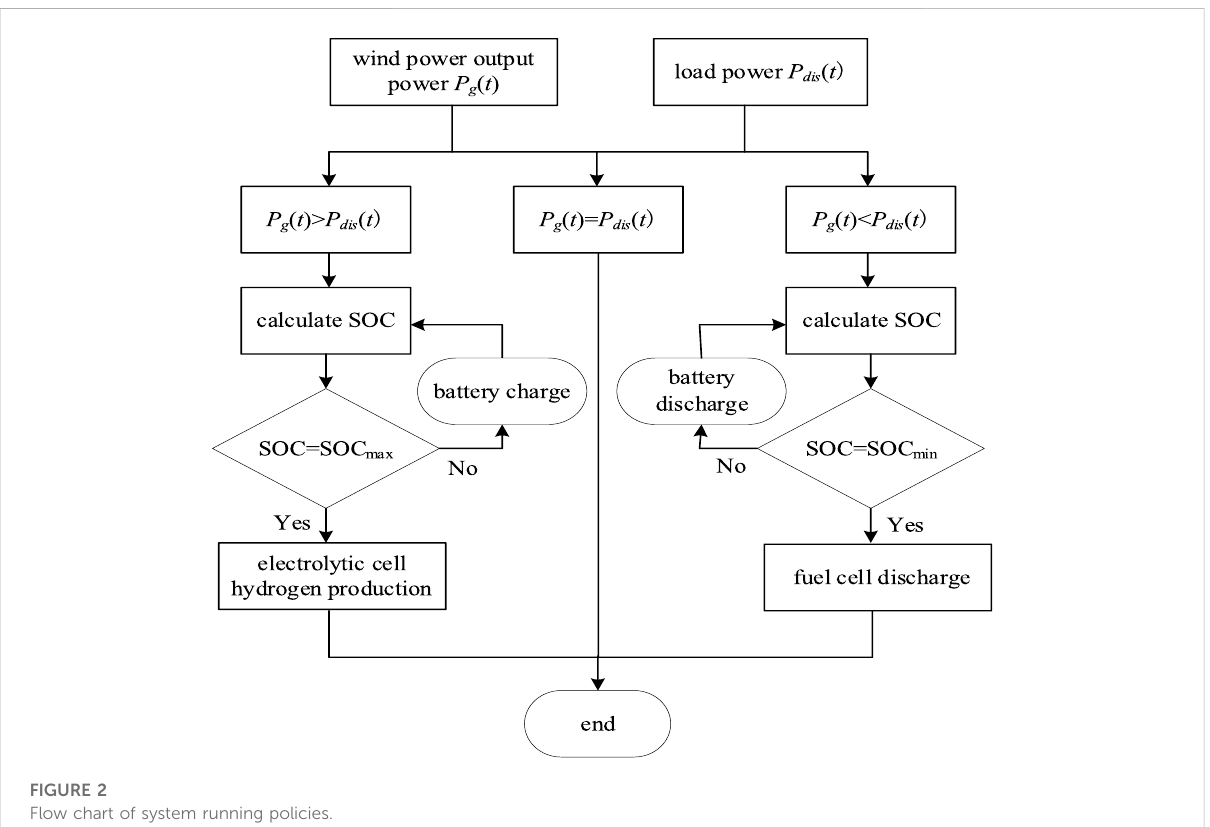
FIGURE 2 Flow chart of system running